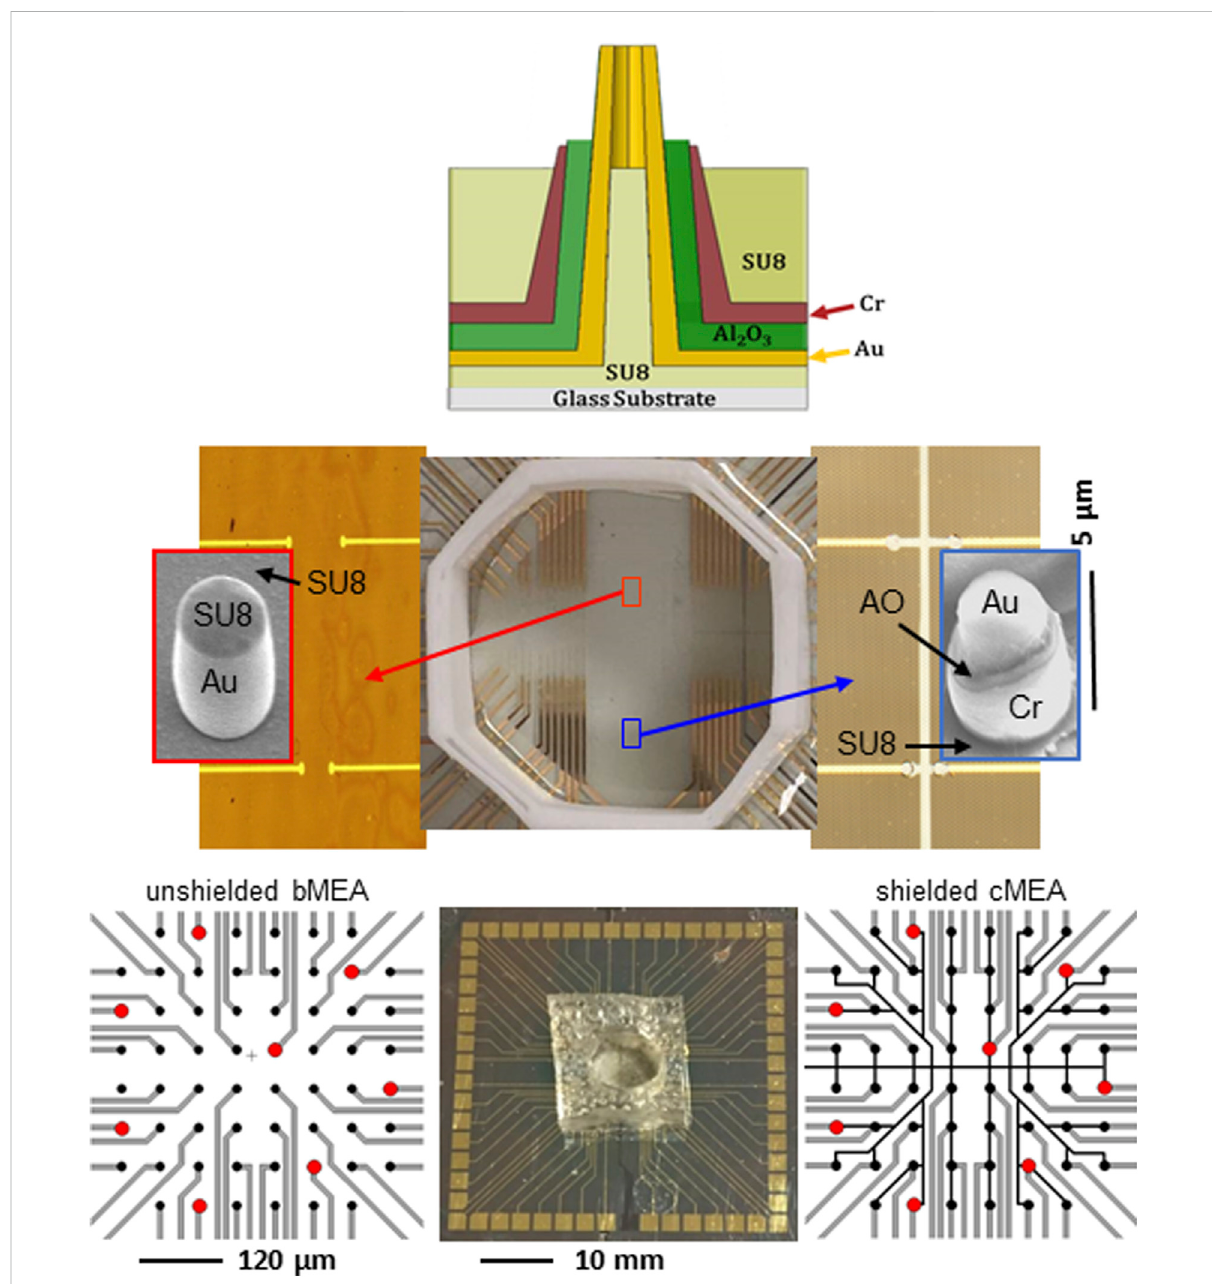
FIGURE 1 Multielectrode array devices used for electrical and optical stimulation. Upper: Schematic of coaxial electrode comprising the cMEA device. Middle: Electrical stimulation device (center) with unshielded, bare electrode/bMEA (left) and shielded, coaxial electrode/cMEA (right) regions. Leftandrightaremagni fi edviewsoftherespective regions, each containingrows ofsensing areaswith varyingseparation. The sensing areasarethe 10 µm in diameter circles at the ends of gold address lines. All areas outside of sensing areas have been passivated (insulated). Zoomed insets show SEMimagesof respective individual,~2µmdiameter,vertically-orientedelectrodes.Constituentmateriallabeled (AO= Al 2 O 3 ).Lower: Optical stimulation device with cMEA chip with well (center), and wiring schematics for bMEA (left) and cMEA (right), both with 10 mm diameter sensing regions (black dots)at 60mm pitch. Red dots indicate 20 mm-diameter transparentareas on thesubstrate and under thesensors,facilitating optical illumination up through the electrode